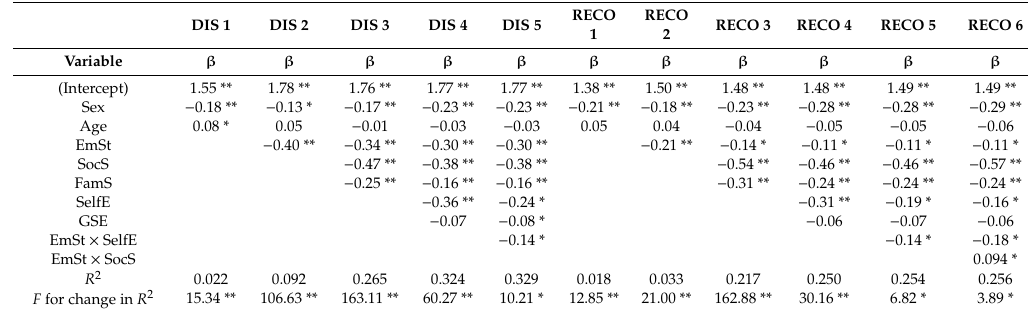
OVRL = stress due to work overload, SOVRL = stress due to social overload, EmSt = employment status (reference category: unemployed), SocS = socialsupport, FamS = familysupport, SelfE = self-esteem, GSE = generalself-e ffi cacy, sex reference category: male, * p < 0.05, ** p < 0.001. Table 5. Summary of nested regression analysis for variables predicting stress resulting from internal demands: stress due to occupational discontent (DIS) and stress due to a lack of social recognition (RECO) ( N = 1390).